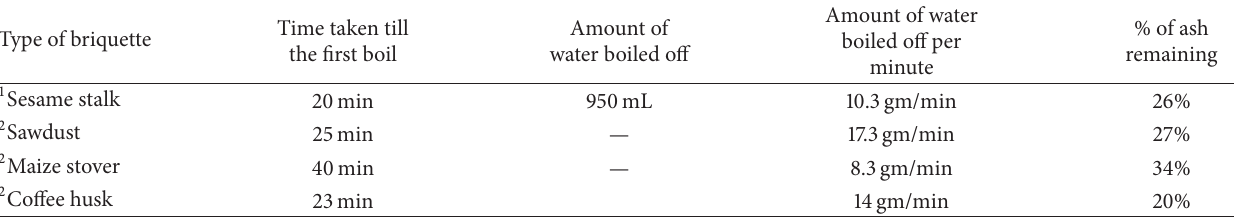
Table 4: Boiling test results: comparison with other biomass resources.